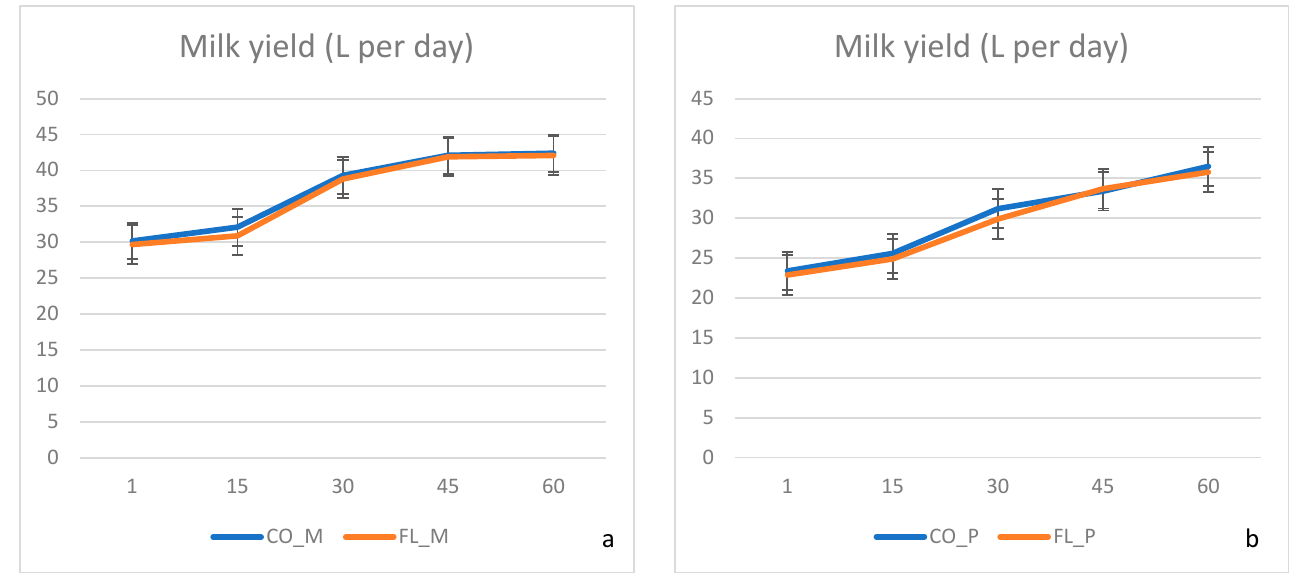
Figure 1. ( a , b ) Mean milk yield during the experimental period 1–60 days postpartum. CO-M: control multiparous cows, FL-M: flaxseed and lupin treated multiparous cows, CO-P: control primiparous cows, FL-P: flaxseed and lupin treated primiparous